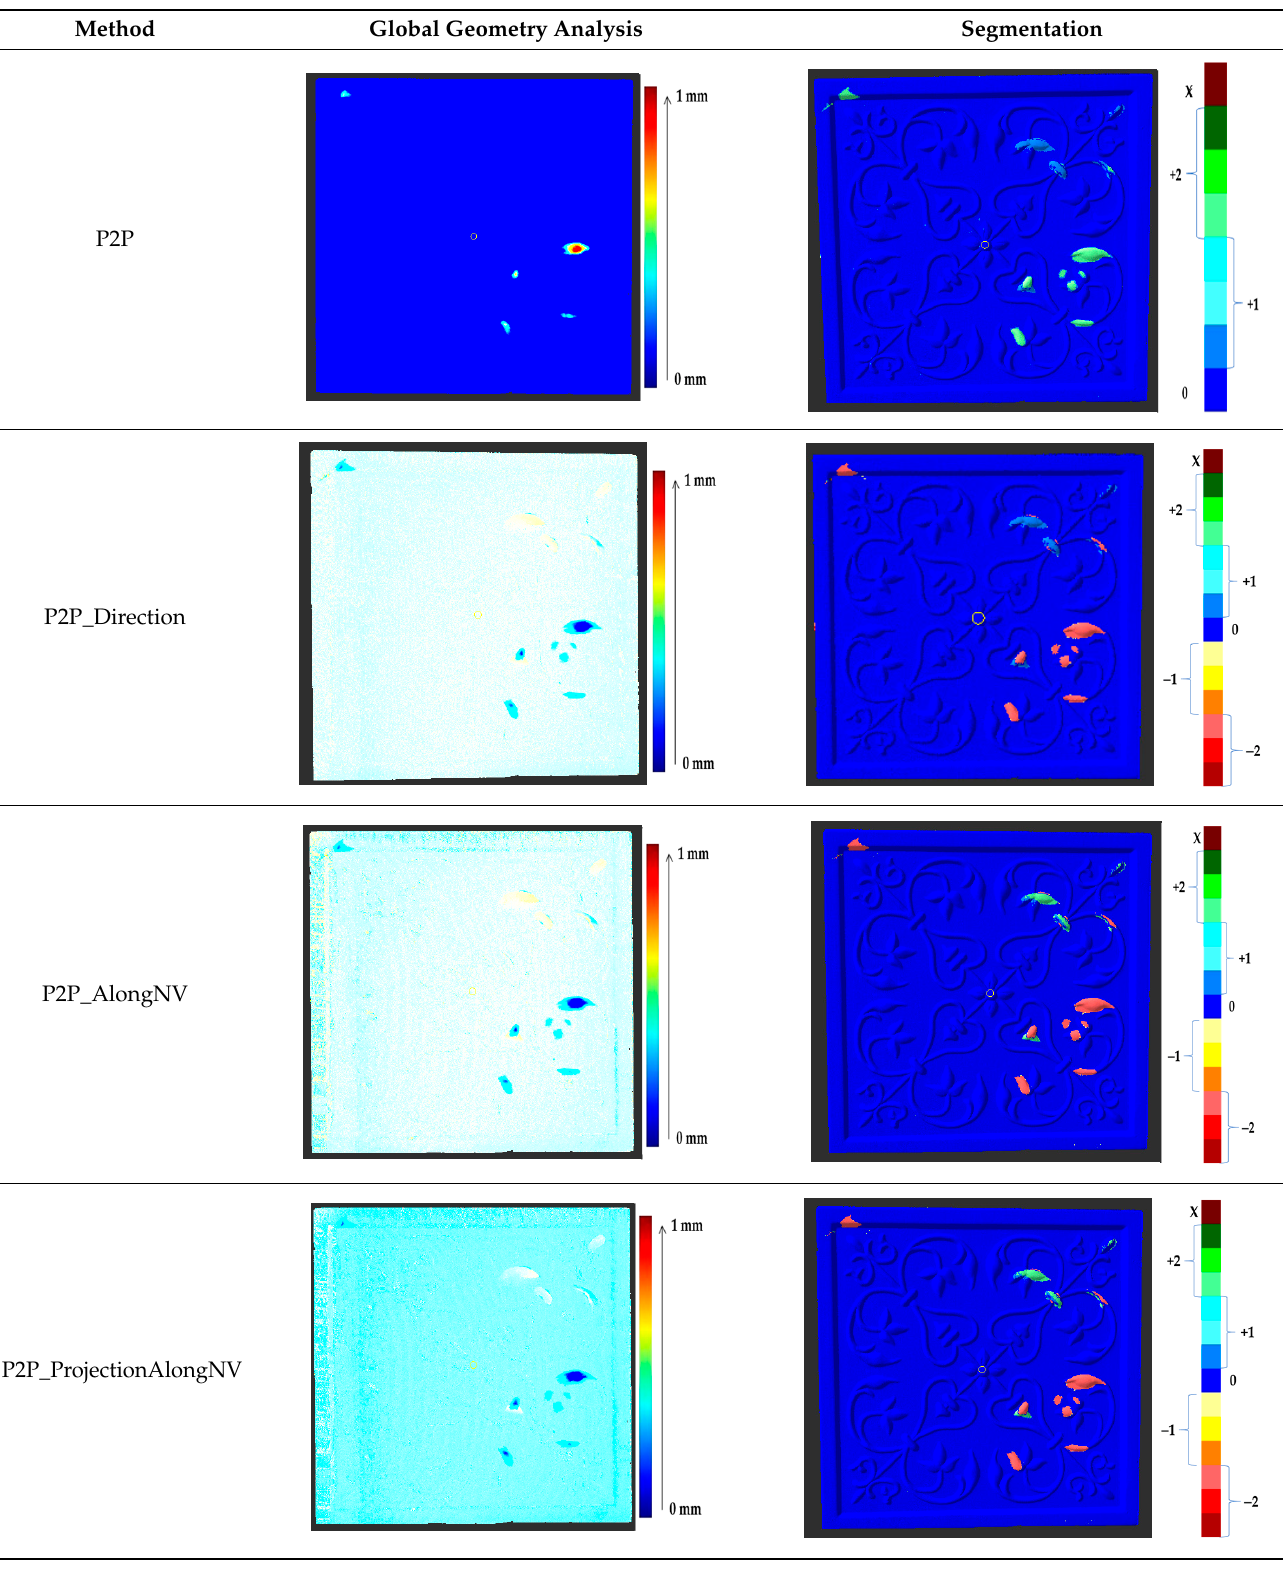
Figure 12. Three-dimensional models of the original surface ( a ) and changed surface ( b ) of Case Study I. Table 7. Correctness of the ground truth table with Nonchanged Threshold.